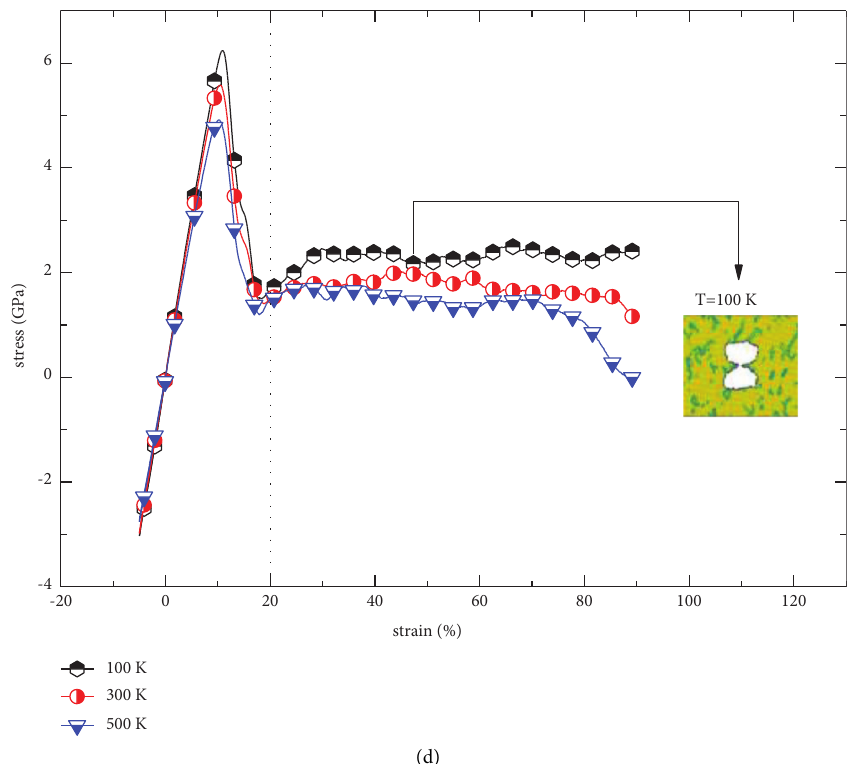
Figure 10: (a–c) The snapshots of the specimen with a strain of 20%; (a) 100k at ε � 20%. (b) 300k at ε � 20%. (c) 500k at ε � 20%. (d) The stress-strain curve at different temperatures.